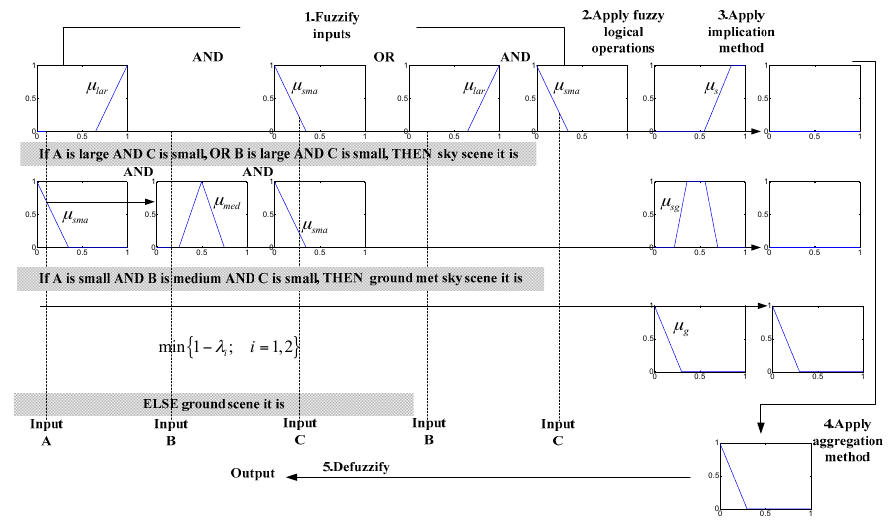
Figure 7. An example of a fuzzy classifier.